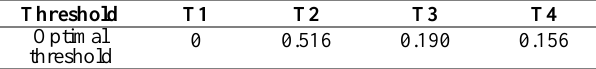
Table1.Threshold extraction results